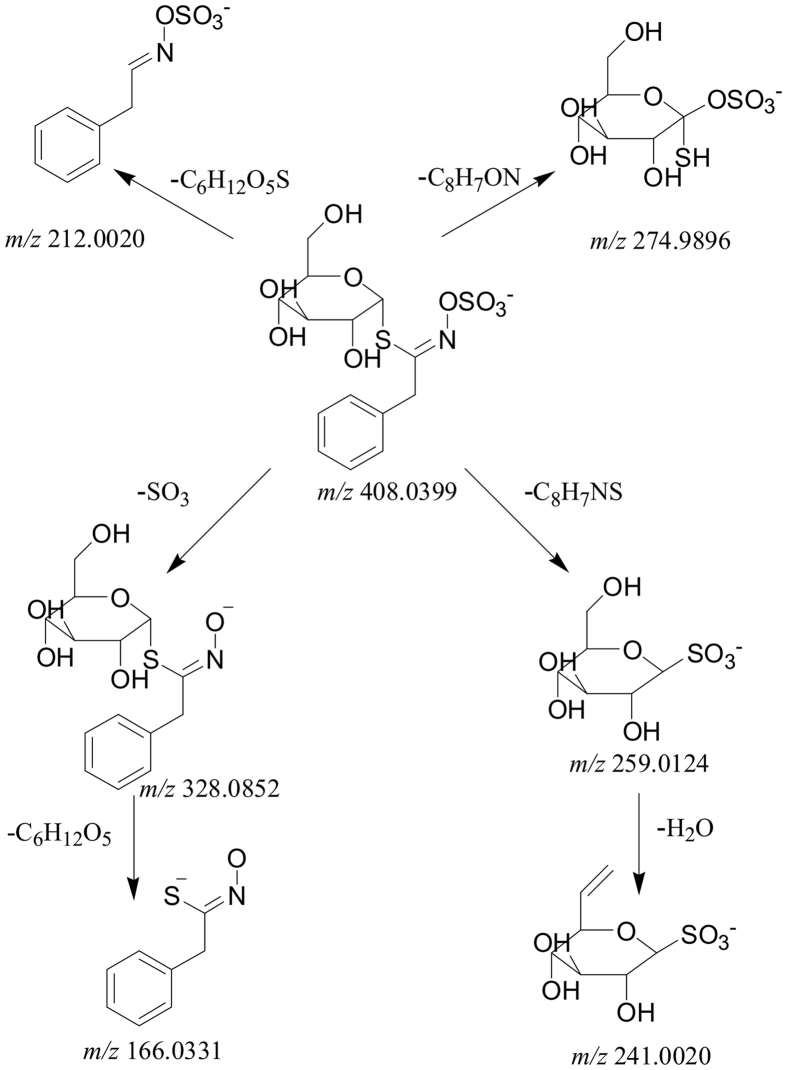
The fragmentation patterns of benzylglucosinolate (No. G5).